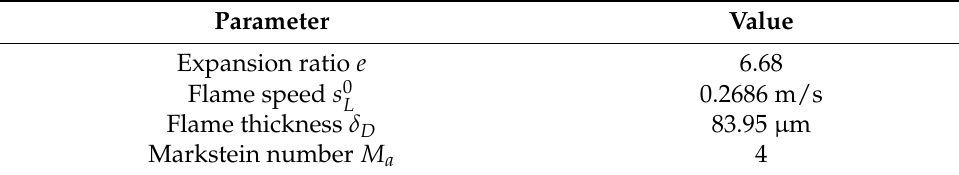
Table 1. Flame parameters used for the analysis of flame-flow